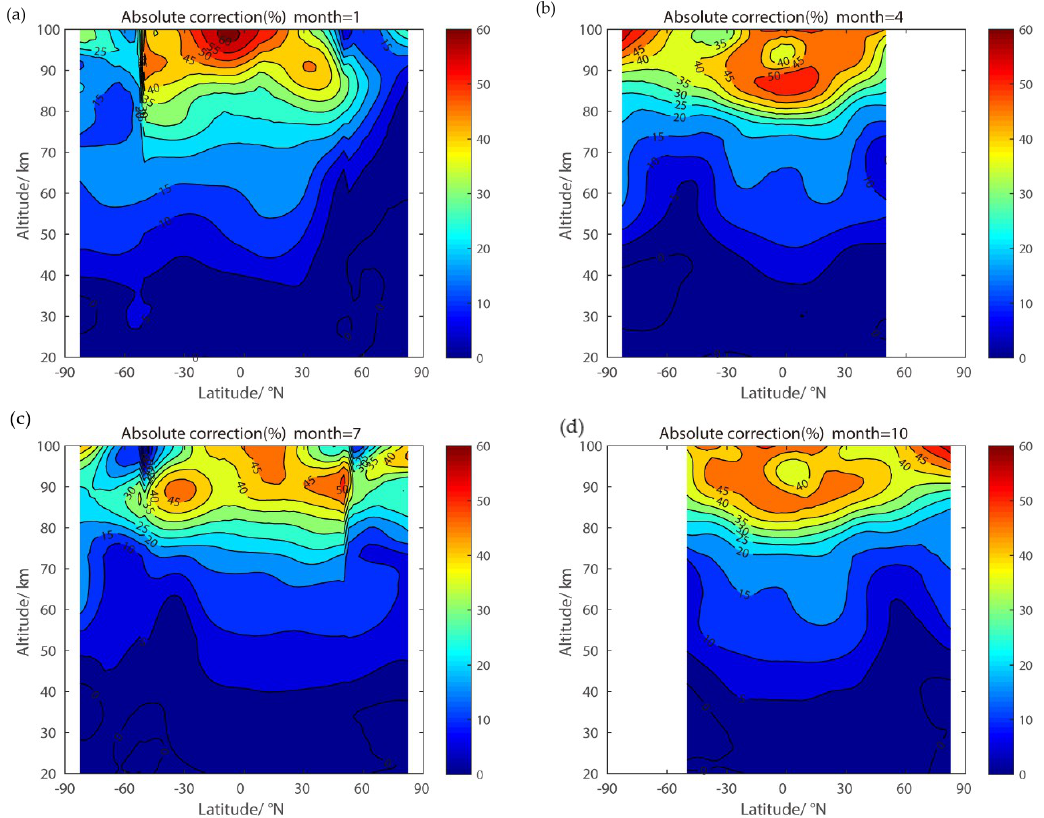
Figure 6. Latitude–height cross-section of ∆ δ in ( a ) January, ( b ) April, ( c ) July, and ( d ) October. ∆ δ = | δ | − | δ | . ∆ δ > 0 indicates that the corrective e ff ect is considerable; ∆ δ < 0 indicates that the correction makes the estimate worse.